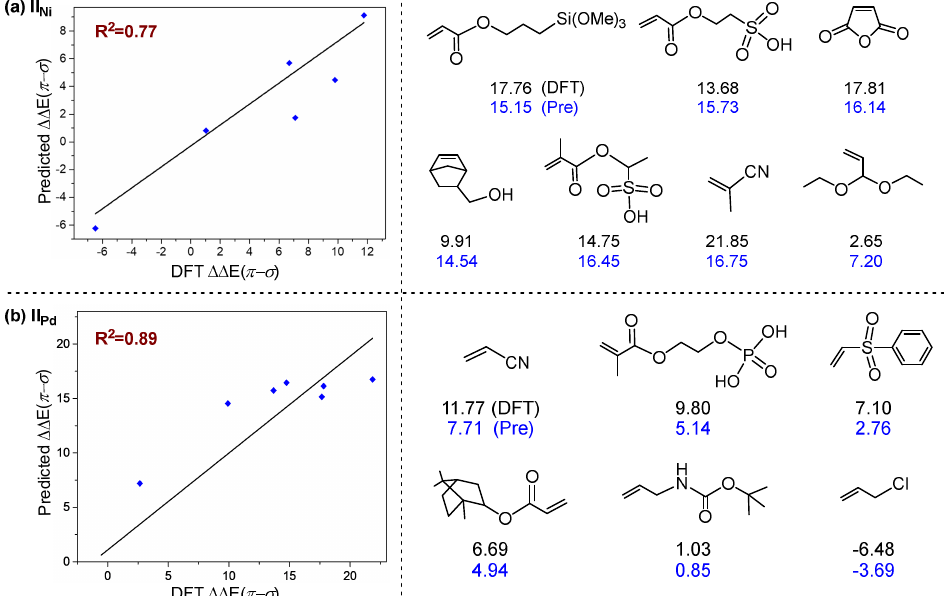
Figure 7. External verification of the multivariate linear regression models for complexes II Ni ( a ) and II Pd ( b ). Blue represents predicted ΔΔ E (π-σ) (kcal/mol), black represents computed ΔΔ E (π-σ) (kcal/mol).